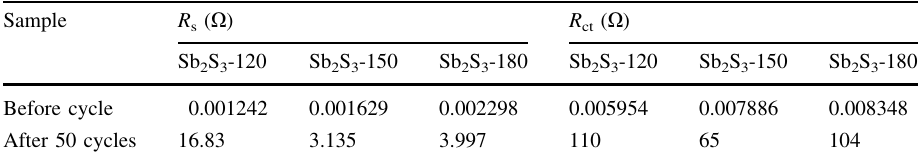
Table 1 The R s and R ct values of Sb 2 S 3 -120, Sb 2 S 3 -150, and Sb 2 S 3 -180 electrodes in LIBs